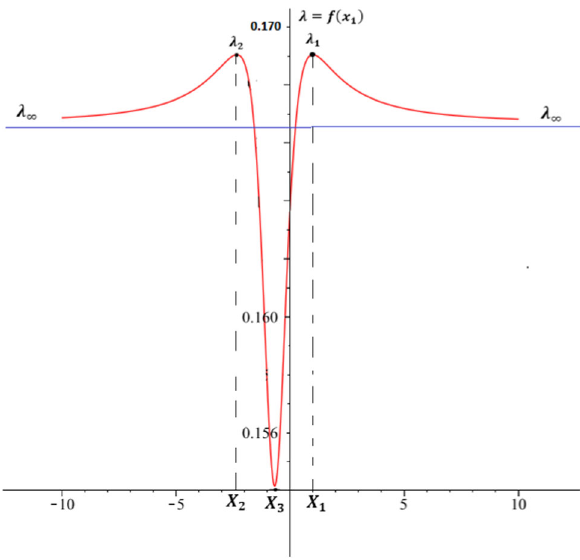
Fig. 4 The function λ = f ( x 1 ) for m = 4, k 1 = k 2 = 5